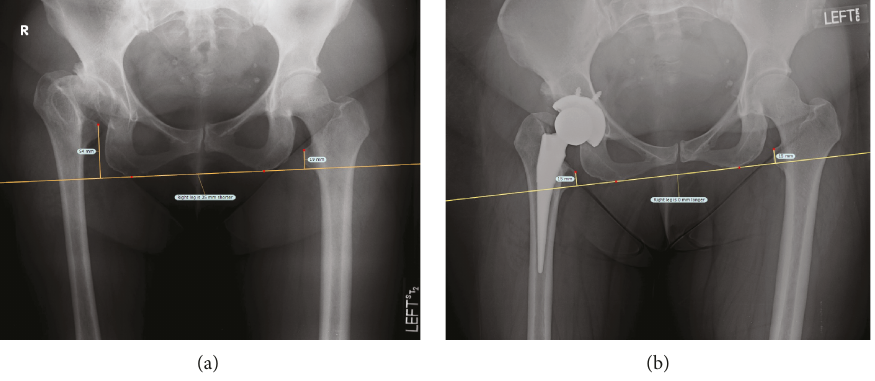
Figure 2: Pre- (a) and postoperative (b) radiographs of Case 2. Preoperative LLD was measured at approximately 3.5cm. Postoperatively, leg lengths were